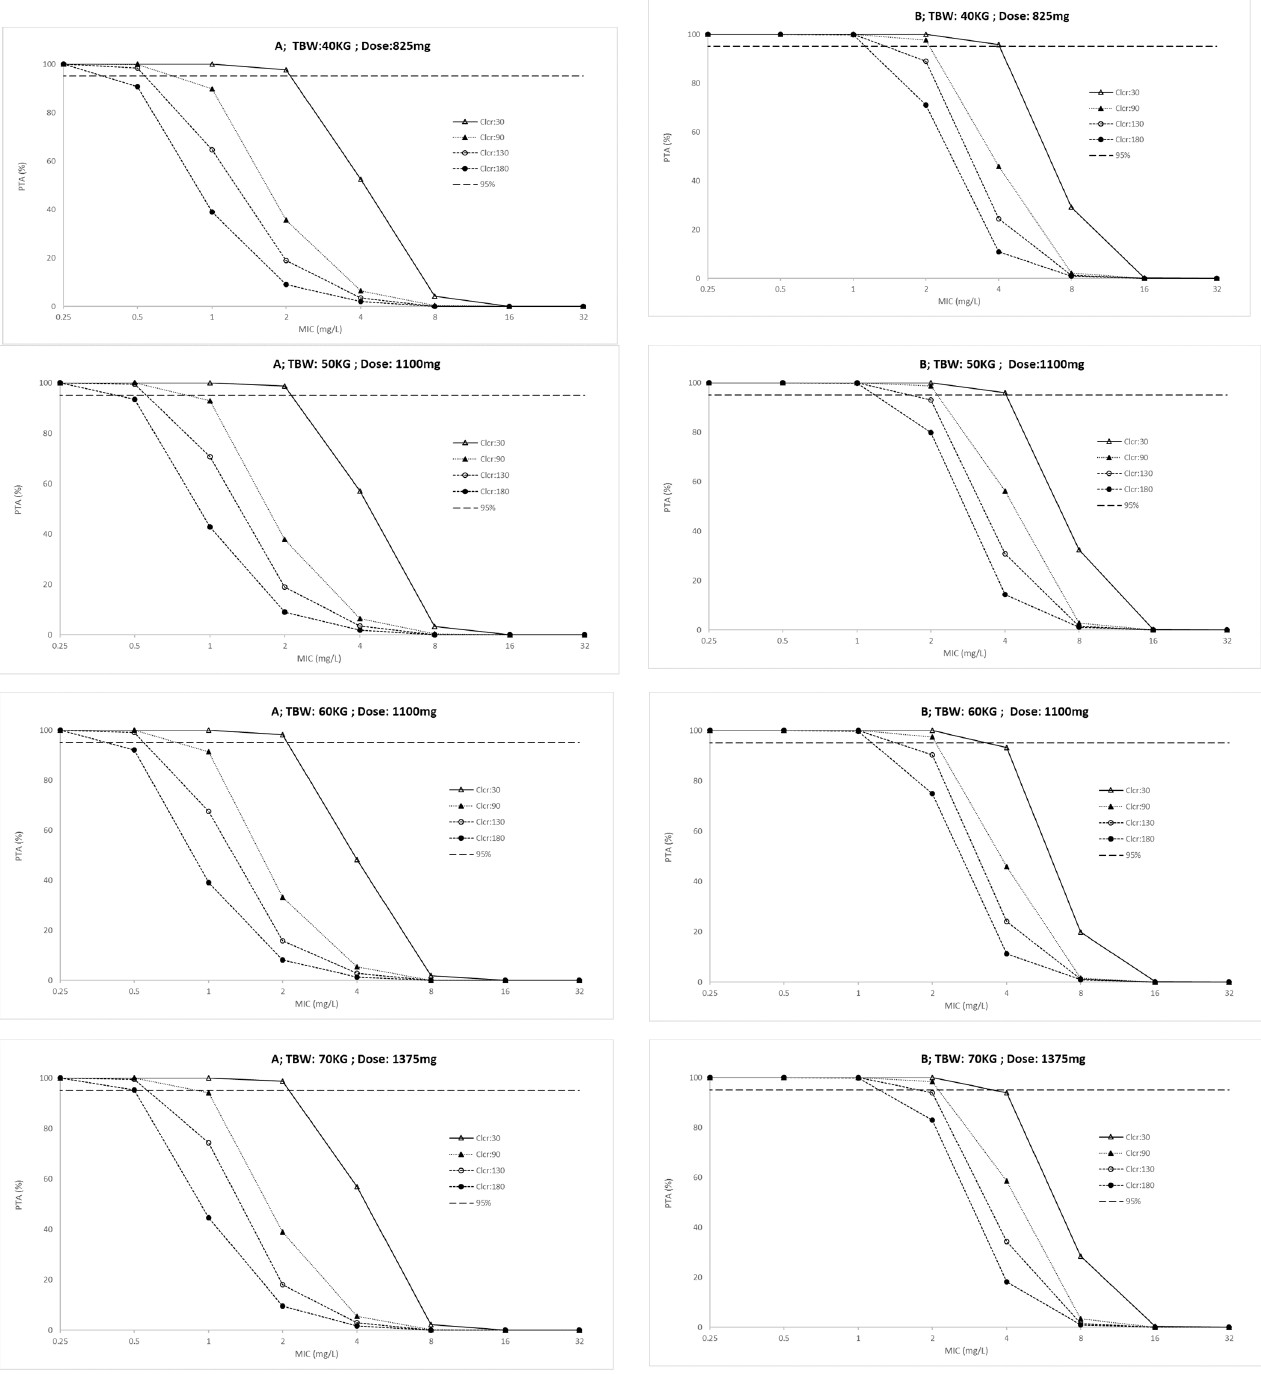
Figure 2. Probability of target attainment ( A : AUC (0–24) /MIC > 11.9 and B : C max /MIC > 0.48) in ICU patients for conventional ethambutol dosing regimen according to total body weight (TBW, 40 to 70 Kg) and creatinine clearance (Clcr, 30 to 180